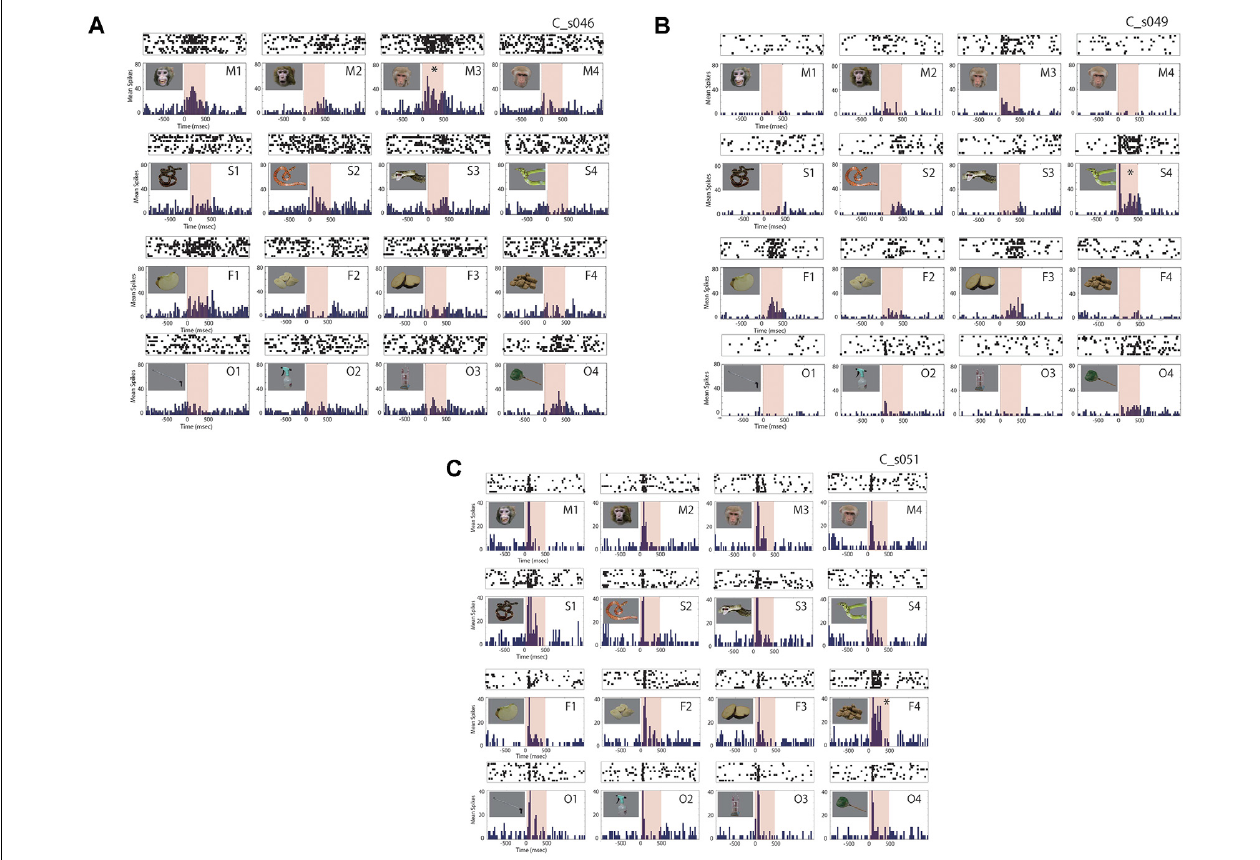
FIGURE 3 | Examples of responses of anterior cingulate neurons. Raster displays and prestimulus time histograms (PSTHs) of the neural activity were aligned to the time of stimulus presentation (time 0). The neuron in panel (A) exhibited the maximal response to a monkey calm face (M3, marked by ∗ ) and the second-best response to a monkey grimace face (M1). The neuron also showed weaker responses to a piece of apple (F1), monkey chows (F4), a snake (S3), and a scoop net (O4). The neuron in panel (B) exhibited the best response to a snake (S4, marked by ∗ ) with a clear response onset after the stimulus presentation. The neurons also showed responses to a monkey calm face (M3), a piece of apple (F1), pieces of sweet potato (F3), and a scoop net (O4). It also showed weaker responses to a monkey threat face (M2), a snake (S2), another snake (S3), pieces of banana (F2), a spray (O2), but did not show any significant response to a monkey grimace